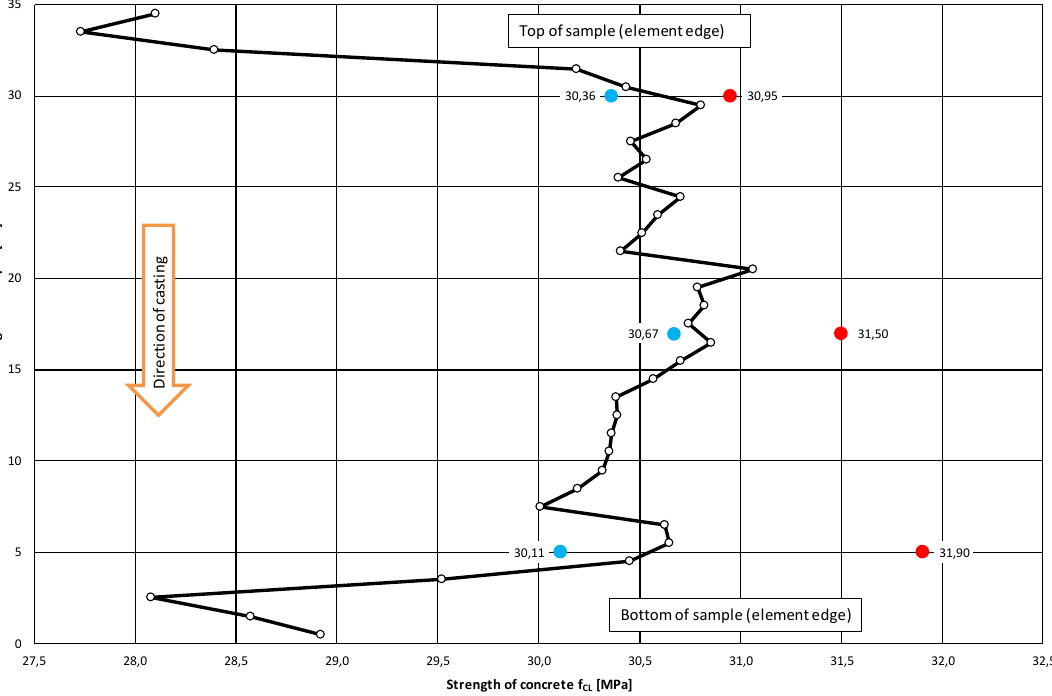
Figure 10. The mean distribution of compressive strength f CL of concrete along the height of the sample taken perpendicularly to top surface of slab. The diagram includes the mean concrete strengths for the top, middle and bottom samples, obtained from ultrasonic tests (marked blue) and destructive tests (marked red).